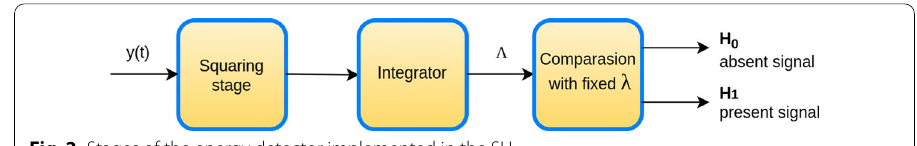
Fig. 2 Stages of the energy detector implemented in the